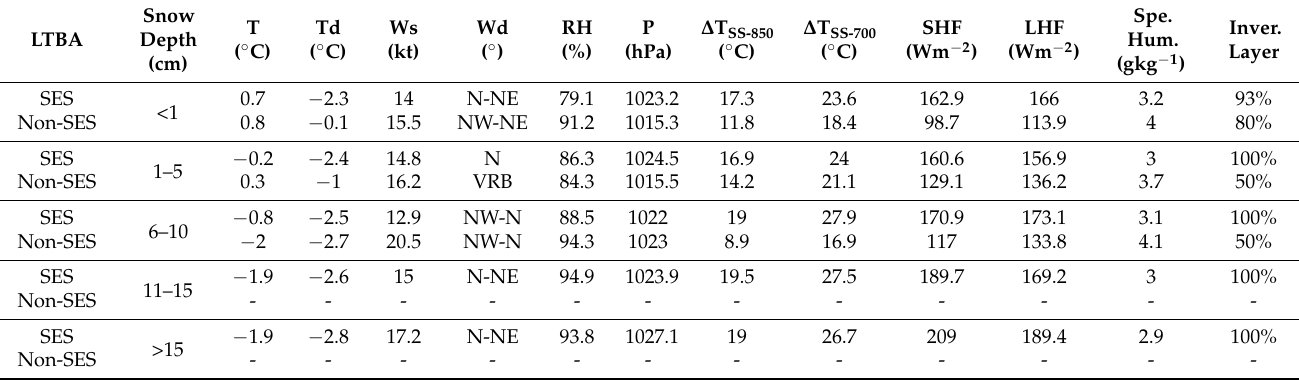
Table 5. Average values of meteorological parameters in SES and non-SES events according to snow depth intervals at LTBA.